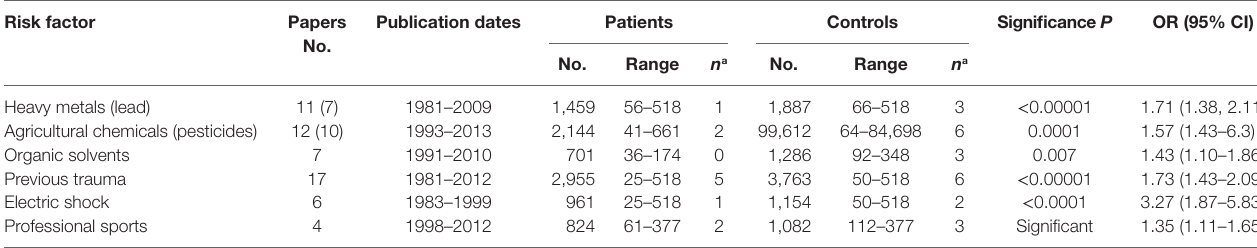
TAbLE 1 | Exposure to environmental factors: results of meta-analyses (5). Risk factor papers